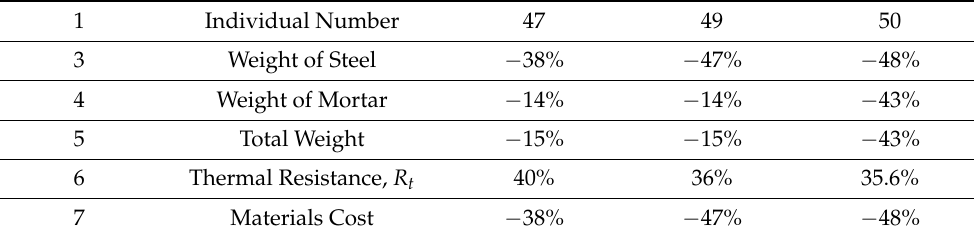
Figure 13. GA search path for cost and thermal resistance optimization excluding panelized members. Table 6. Comparison of Pareto-Optimal Solutions to Base